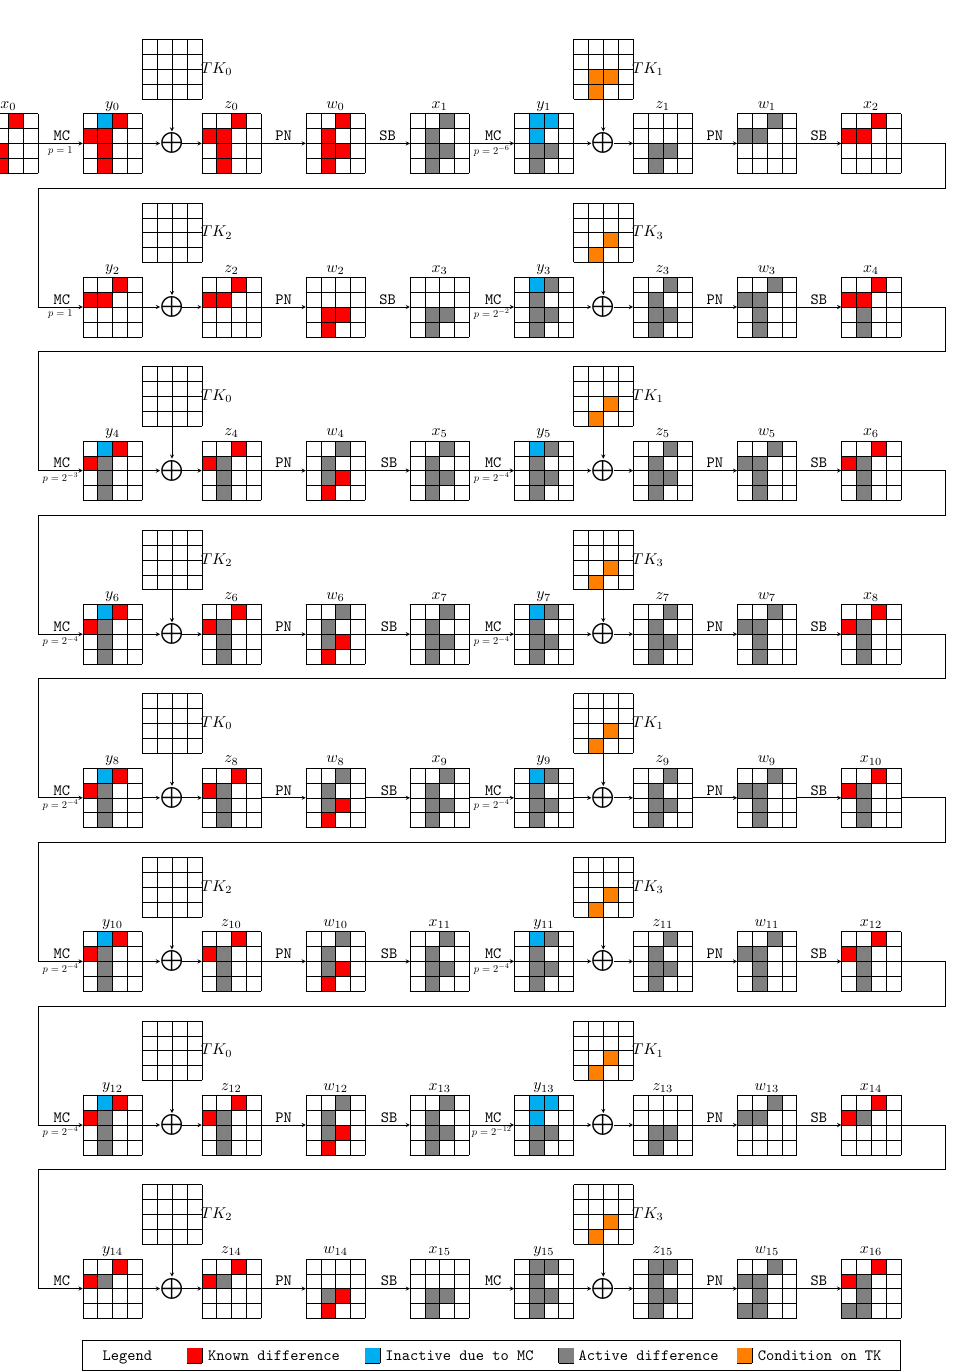
Figure 4: A 16-round truncated differential trail of CRAFT with probability 2 − 55